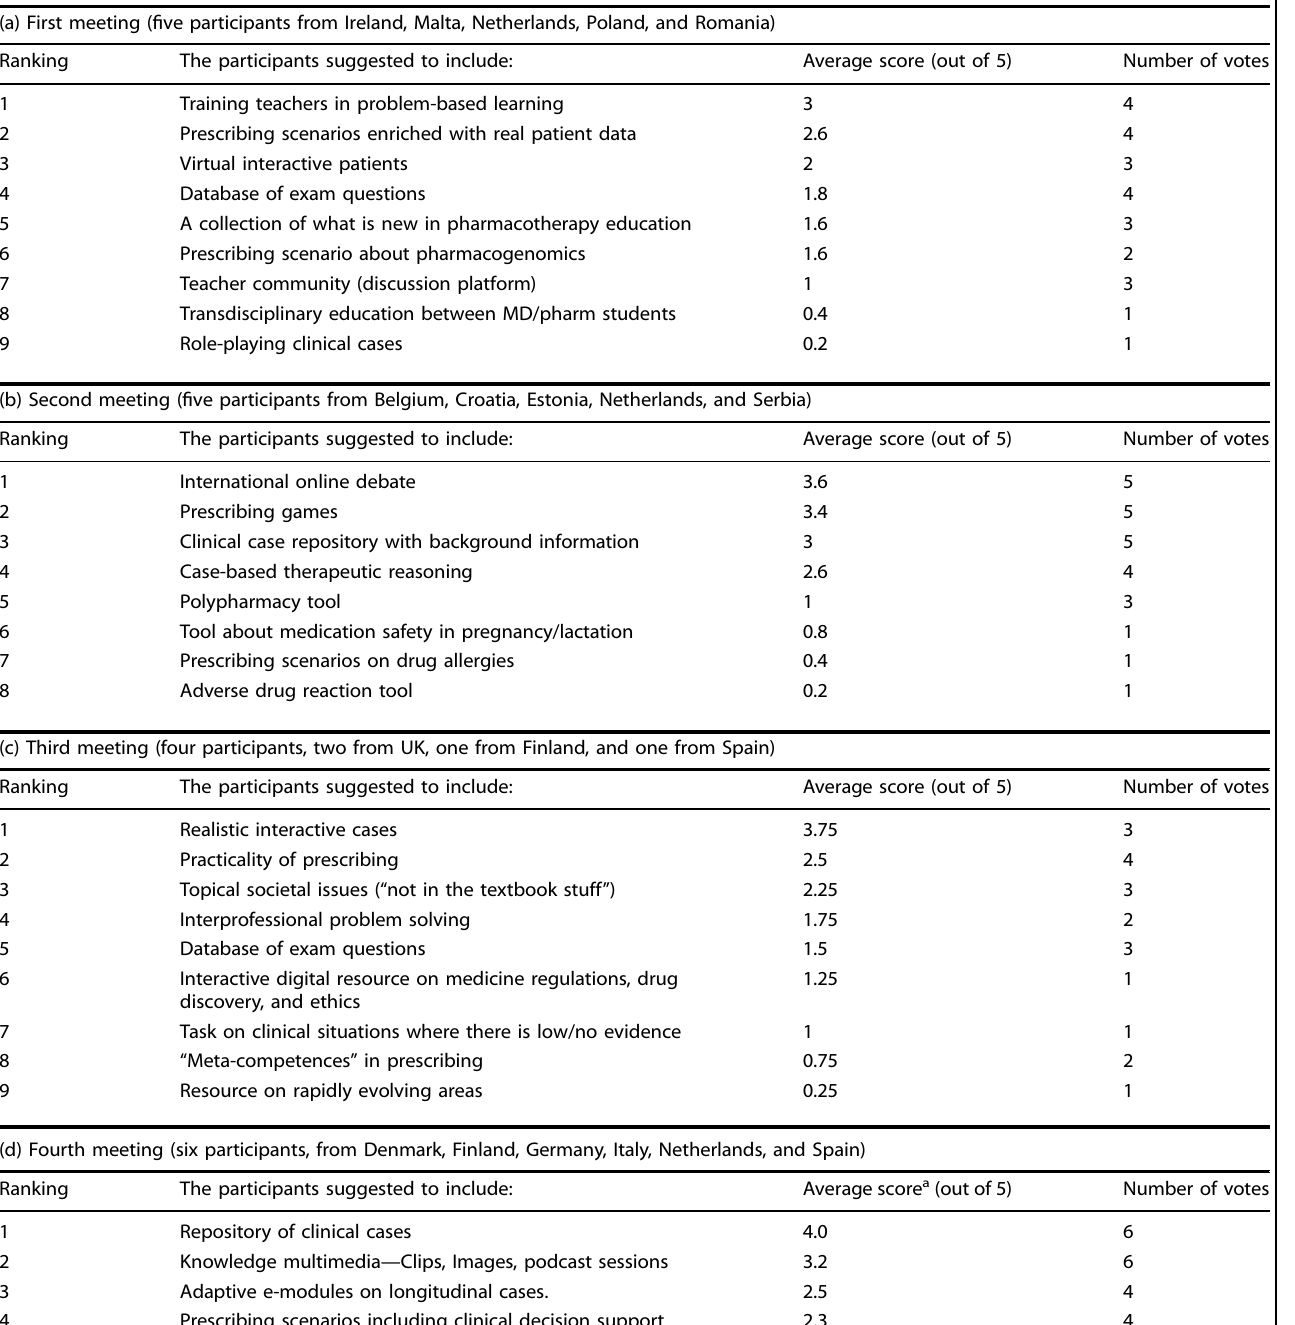
Table 2. Nominal group